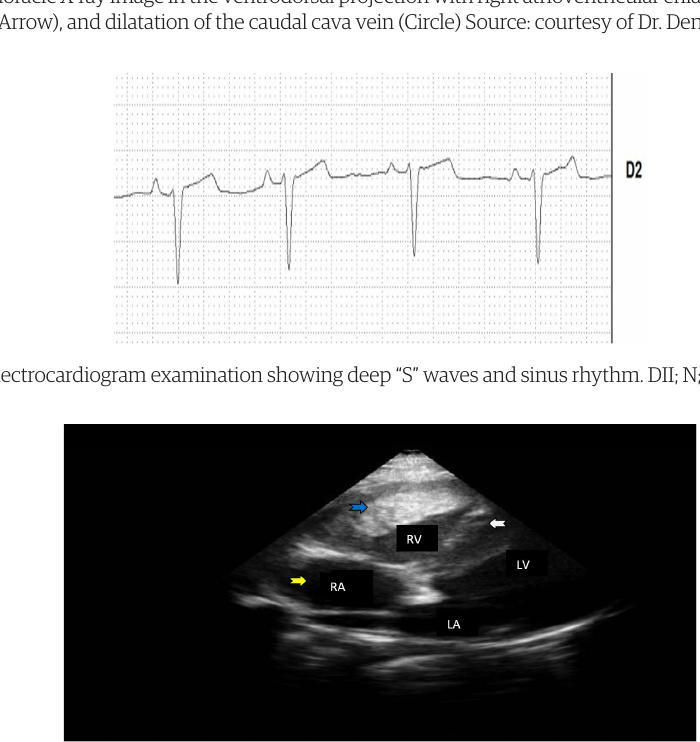
Figure 3. Echocardiographic image of left parasternal window, four-chamber apical section showing increased right atrium in the subjective analysis (yellow arrow), concentric hypertrophy of the right ventricle (blue arrow) and interventricular septal hypertrophy (white arrow). RA = right atrium; LA = left atrium; RV = right ventricle; LV = left